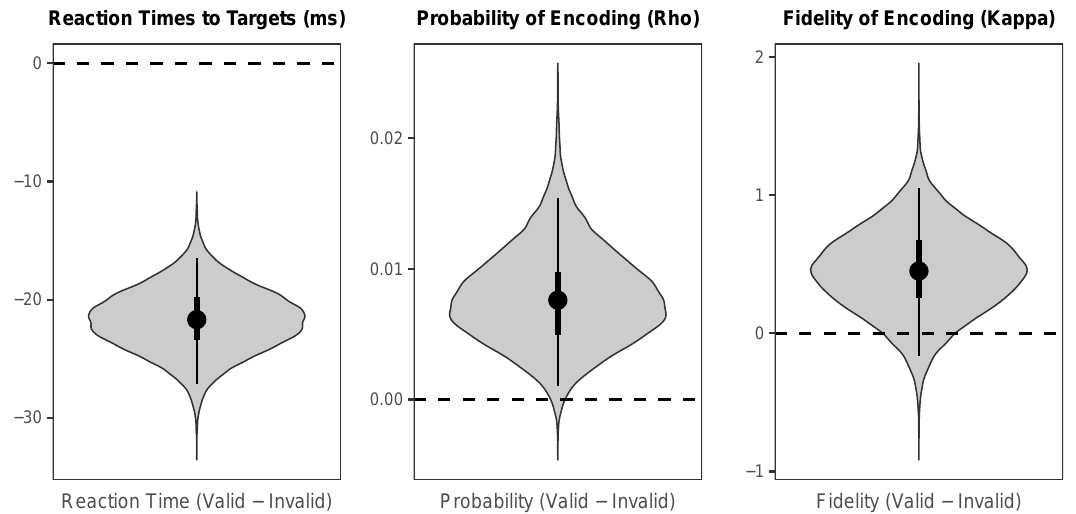
Figure 5. The probability distributions for the effects of cueing (Valid minus Invalid) for each parameter of interest for endogenous